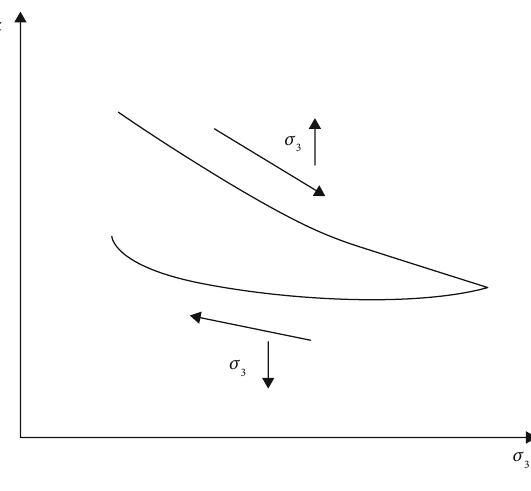
Figure 11: The con fi ning pressure-permeability